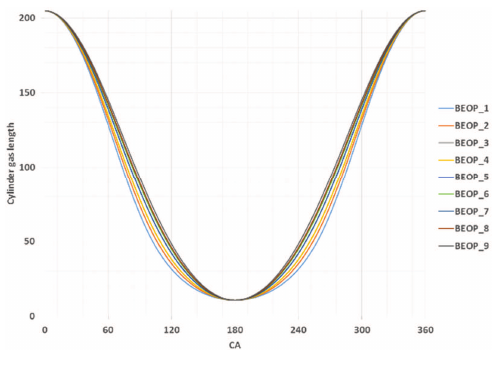
Fig. 15. BEOP piston motion curves 4. Model of the engine All engines have been represented by a closed-cycle numerical model. The incylinder paramters where based on the ideal gas properties. The gas model was built based on the ideal gas mixture of the following species: nitrogen (N), oxygen (O ), argon (Ar), carbon dioxide (CO ), water 2 2 (H O) and isooctane (C H ). The molecular mass, volume 2 8 18 and mass fractions where determined for each time step. The specific heat of the gas was determined based on